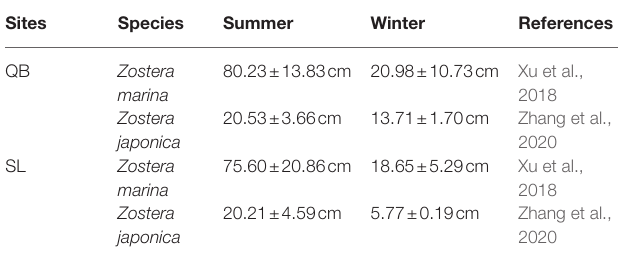
TABLE 1 | Shoot heights of Zostera marina and Zostera japonica in QB and